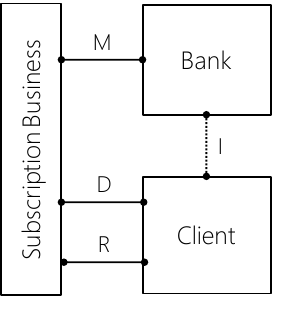
Figure 26. Subscription Pattern.